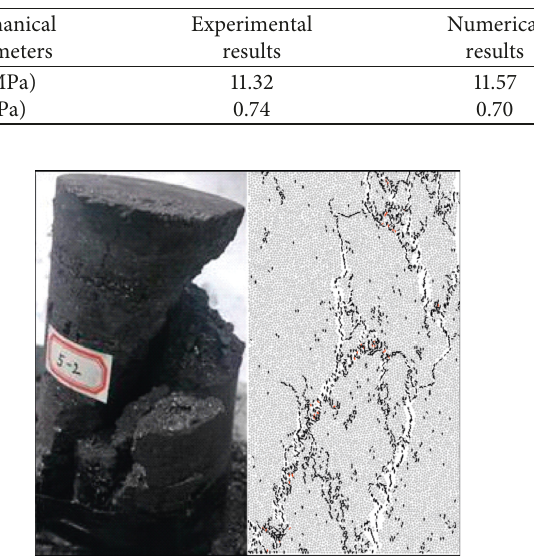
Table 3: Comparison between the experimental and numerical mechanical parameters.